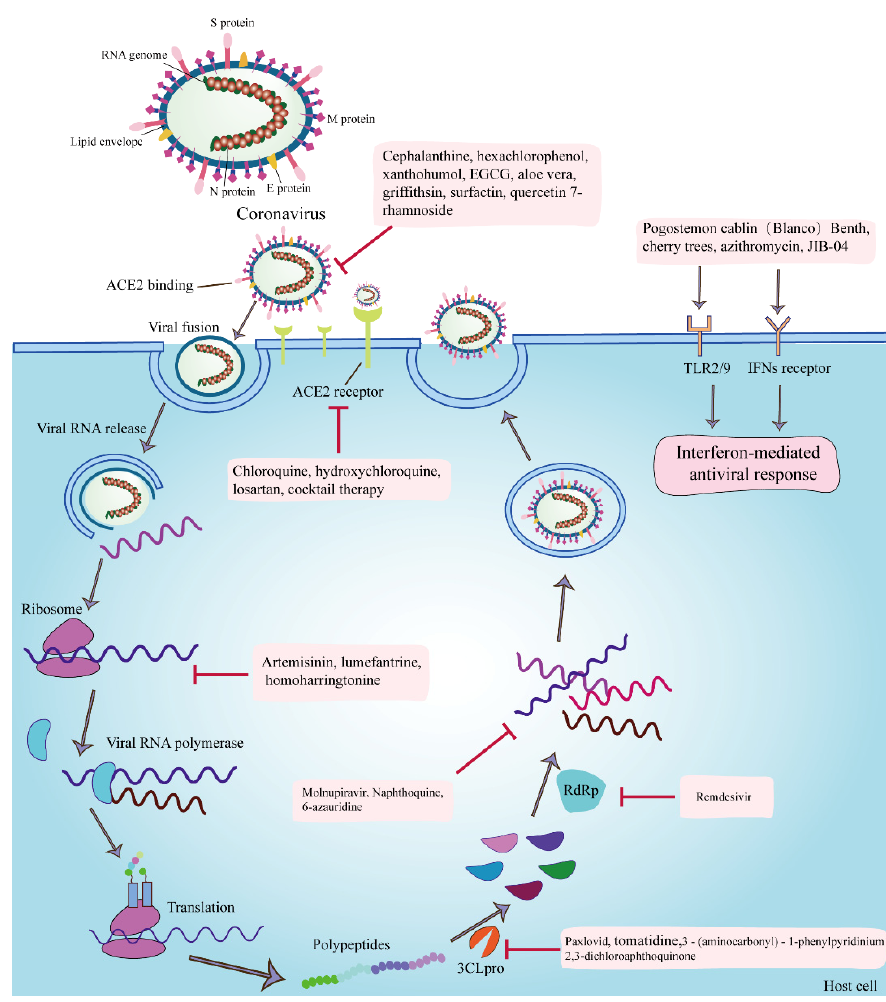
Figure 1. The targets of anti-coronavirus drugs and the infection processes of coronavirus. The anti-coronavirus mechanisms or targets of cepharanthine are the inhibition of viral invasion through binding to the S protein; hexachlorophenol and xanthohumol are the antagonization of the Mpro; EGCG is the inhibition of the attachment, entry, replication, and assembly of viruses; aloe vera is the direct inactivation of PEDV; Griffithsin and surfactin are the inhibition of the viral attachment; quercetin 7-rhamnoside is the inhibition of the initial stage of viral infection; chloroquine, hydroxychloroquine, losartan, and cocktail therapy for coronavirus are the inhibition of the invasion of viruses by inhibiting the binding of SARS-CoV2 to the ACE2 receptor; artemisinin, lumefantrine, and homoharringtonine are the inhibition of the synthesis of early protein; Paxlovid, tomatidine, 3-(aminocarbonyl)-1-phenylpyridinium, and 2,3-dichloroaphthoquinone are the inhibition of the 3CLpro; remdesivir is the inhibition of the RdRp and nucleoside components; molnupiravir, naphtho- quine, and 6-azauridine are the inhibition of the synthesis of viral RNA; Pogostemon cablin (Blanco) Benth and JIB-04 are the stimulation of antioxidant- and H3-mediated antiviral immune responses; and azithromycin exerts antiviral effects by inducing type I interferon immune